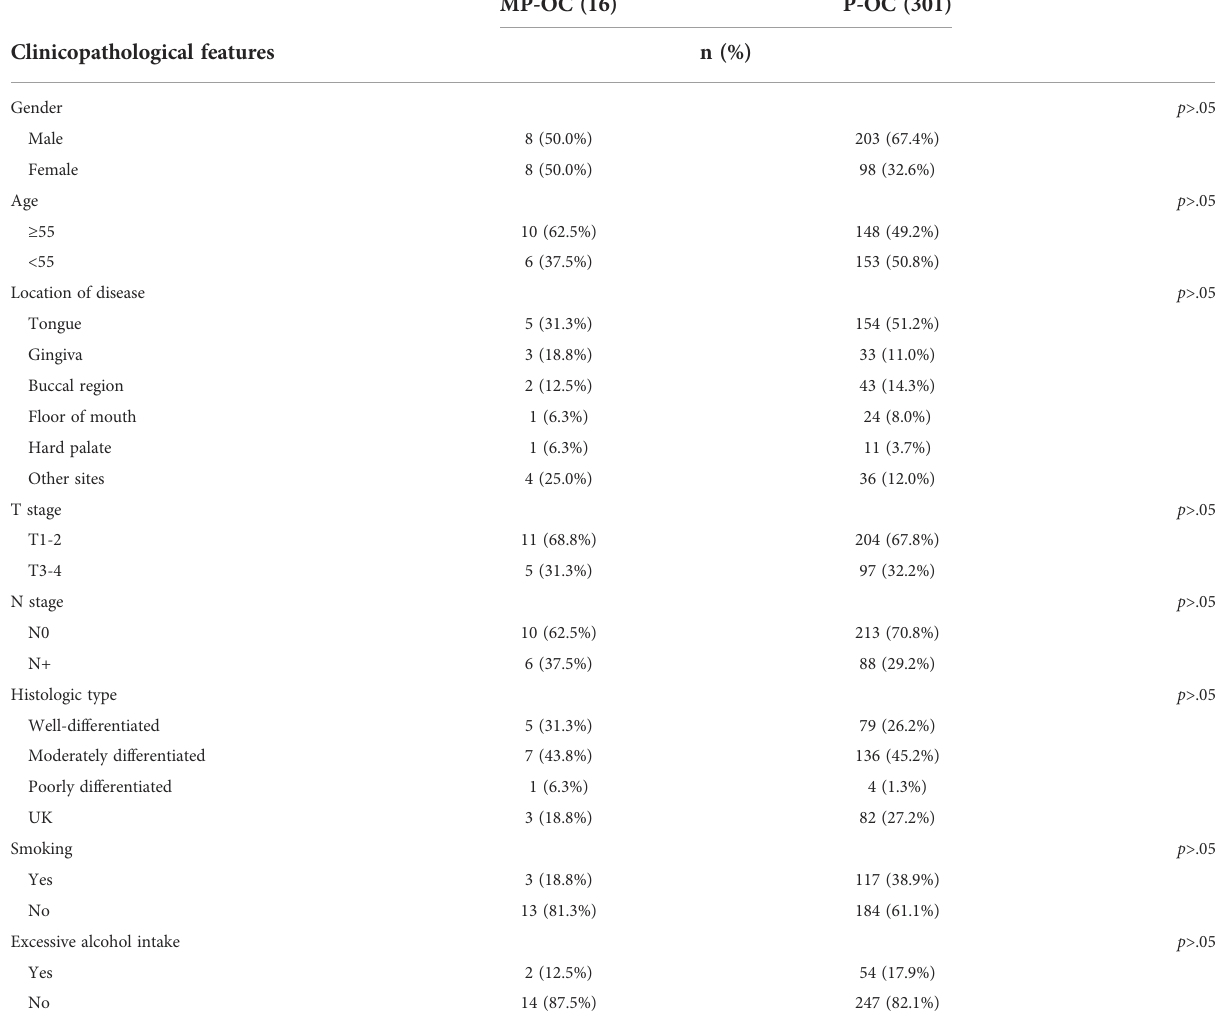
TABLE 1 Clinicopathologic features of 317 patients for